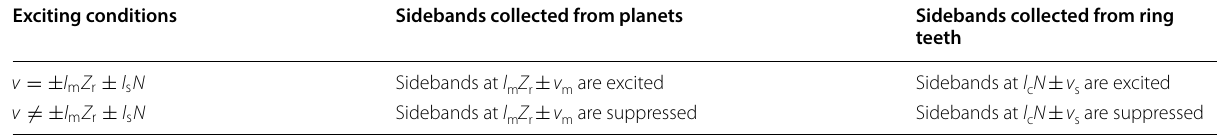
Table 6 Exciting conditions for mesh sideband Exciting conditions